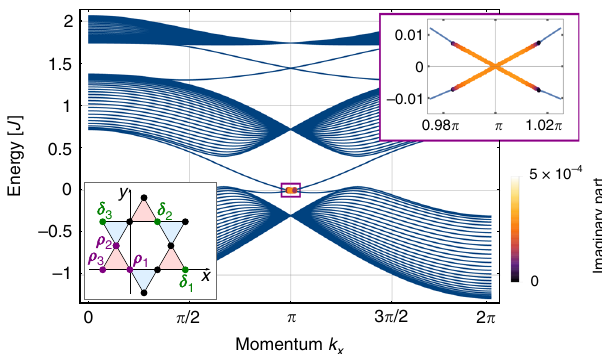
Fig. 1 Magnon band structure and instability. The band structure of a kagome topological magnetic insulator (TMI) strip with a drive tuned to the edge modes at momentum π (lattice constant a = 1), calculated from the microscopic model described in the text. Instabilities are marked by coloured disks, with the colour representing the size of the imaginary part, in units of J . Bottom left (grey) inset: A sketch of a few unit cells of the kagome lattice, with lattice vectors δ i (| δ i | = a = 1) and site vectors ρ i drawn in. The system we consider is in fi nite along the x -direction and comprises W = 45 unit cells along the y -direction. Top right (purple) inset: Zoom of the unstable region. Parameters: D z / J = 0.2, h / J = 0.01, Ω 0 / J = 2.578,